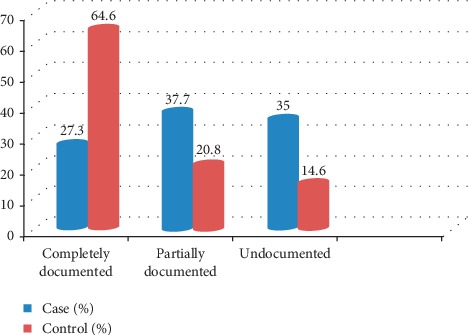
Bar graph showing status of partograph documentation for cases and controls among women who delivered in public hospitals of Addis Ababa, Ethiopia, 2019.